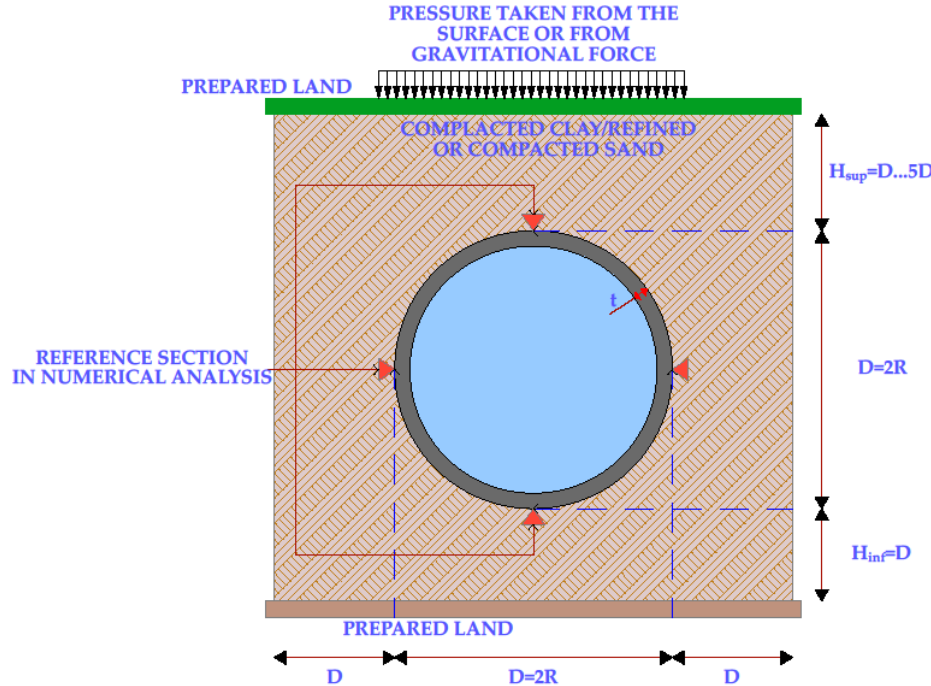
Figure 2. Notations and hypotheses for modeling underground